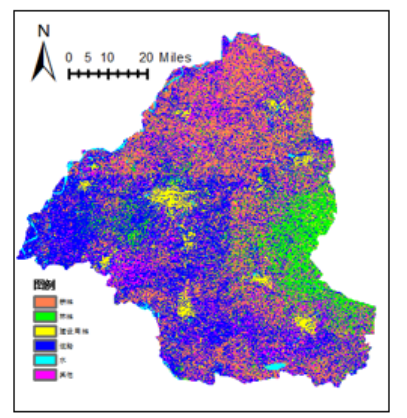
Figure 6 ． Result of K-means classification